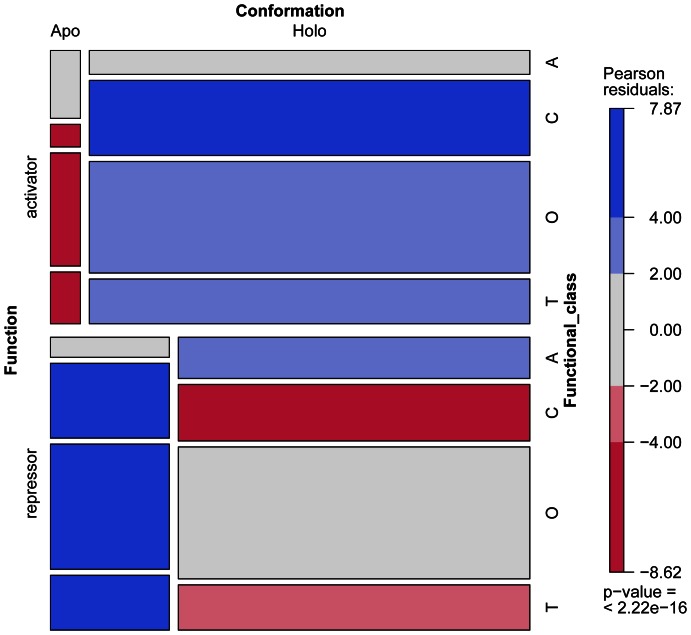
Gene classification based on MultiFun and TF conformational bias.Each gene was classified by its regulation, on the function of the TF (activator or repressor), the conformation (apo or holo), and functional class (T: transport; O: others; C: catabolic; A: anabolic). This plot represents a contingency table, with each rectangle corresponding to a piece of the plot, with their sizes proportional to the cell entry. The Pearson residuals indicate the fit of a log-linear model. Blue represents the maximum significance of the corresponding residual, and red shows the minimum.